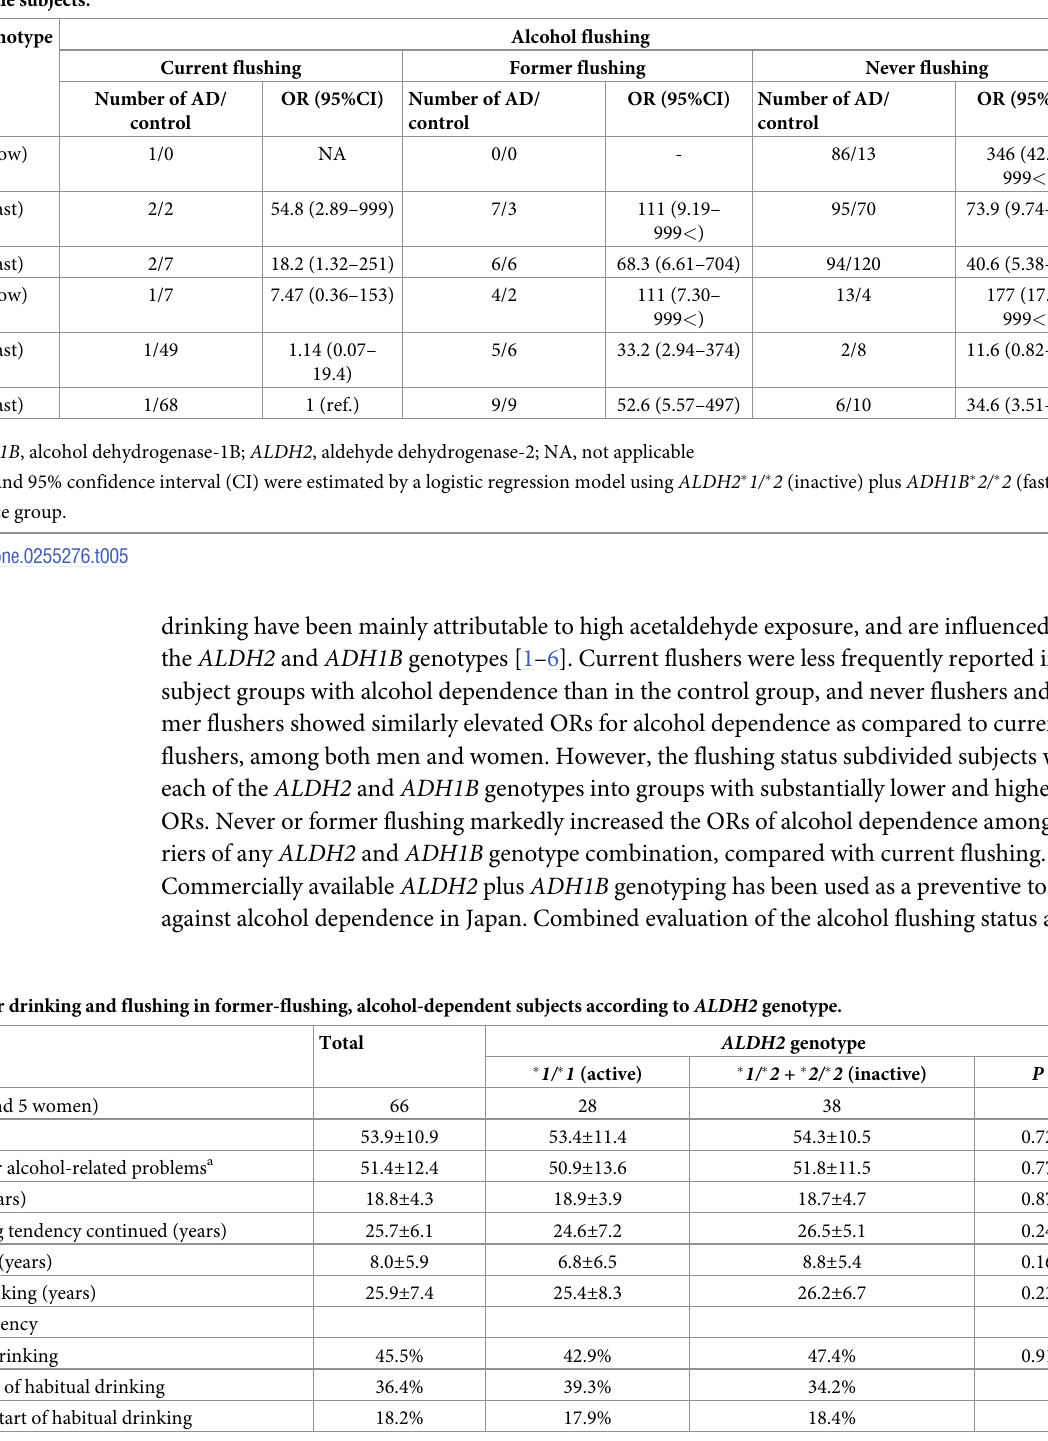
Table 5. Age-adjusted odds ratios (95% confidence intervals) of alcohol dependence according to the combinations of alcohol flushing status and ALDH2 and ADH1B genotypes in the female